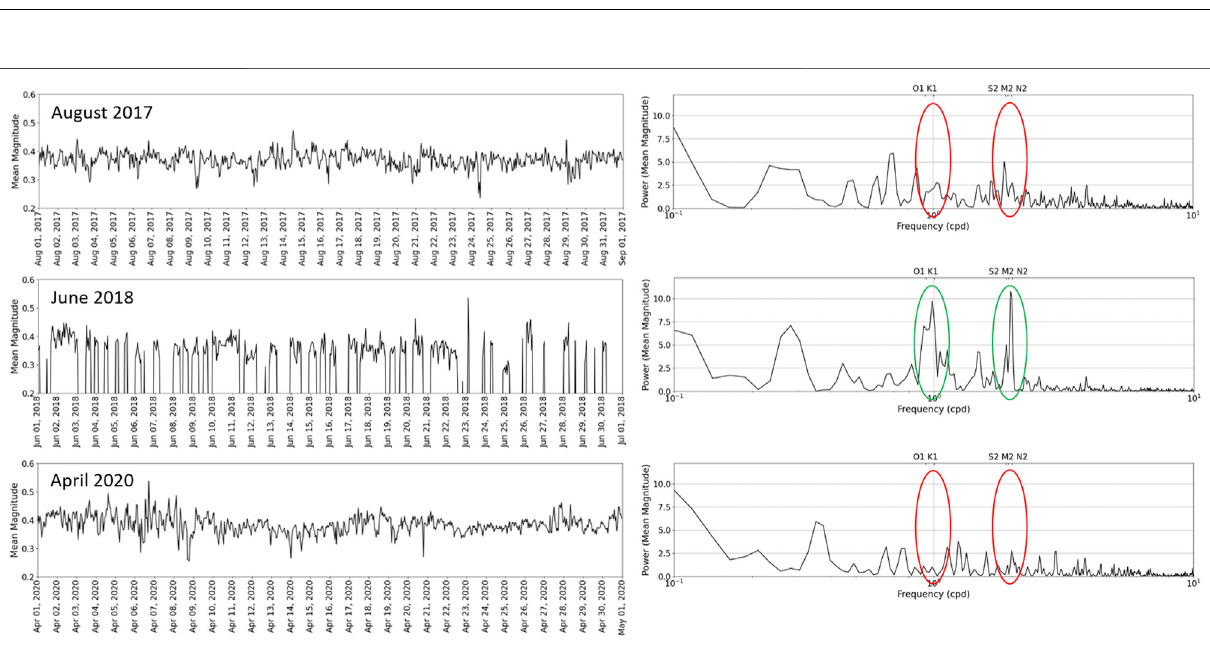
Frontiers in Earth Science |